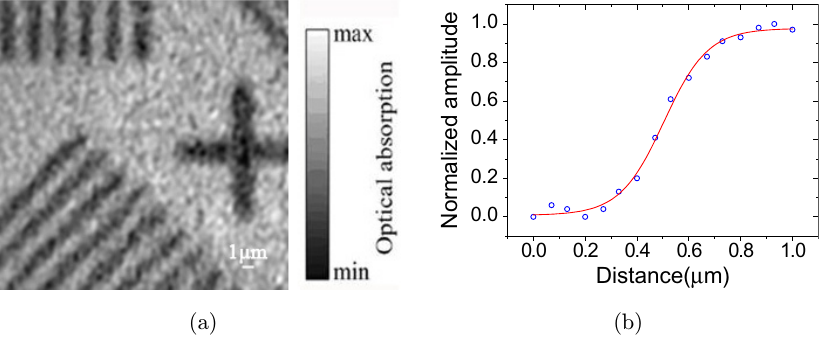
Fig. 3. Lateral resolution of the OR-PAM system. (a) PAM image of the resolution test target (RTA-07). (b) By ¯tting the ESF given by the bars, the lateral resolution is quanti¯ed as 0 : 50 (cid:5) 0 : 05 (cid:2) m. The blue circles denote the experimental data, and the red curve is the theoretical ¯t.